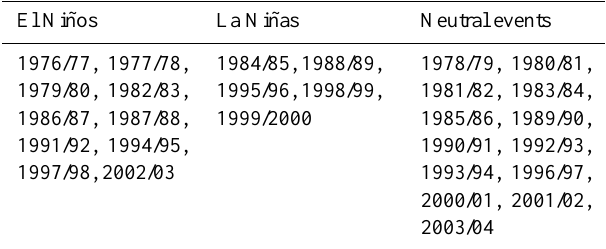
Table 1. El Ni˜no, La Ni˜na and neutral events selected according the Oceanic Ni˜no Index (ONI)/NOAA